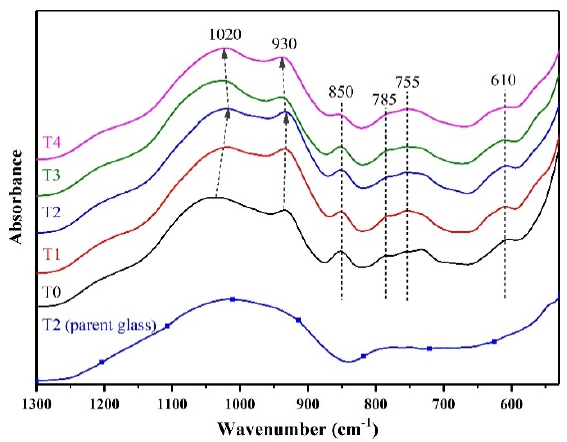
Figure 3. FT-IR of parent glass and T0-T4 LAS GCs.